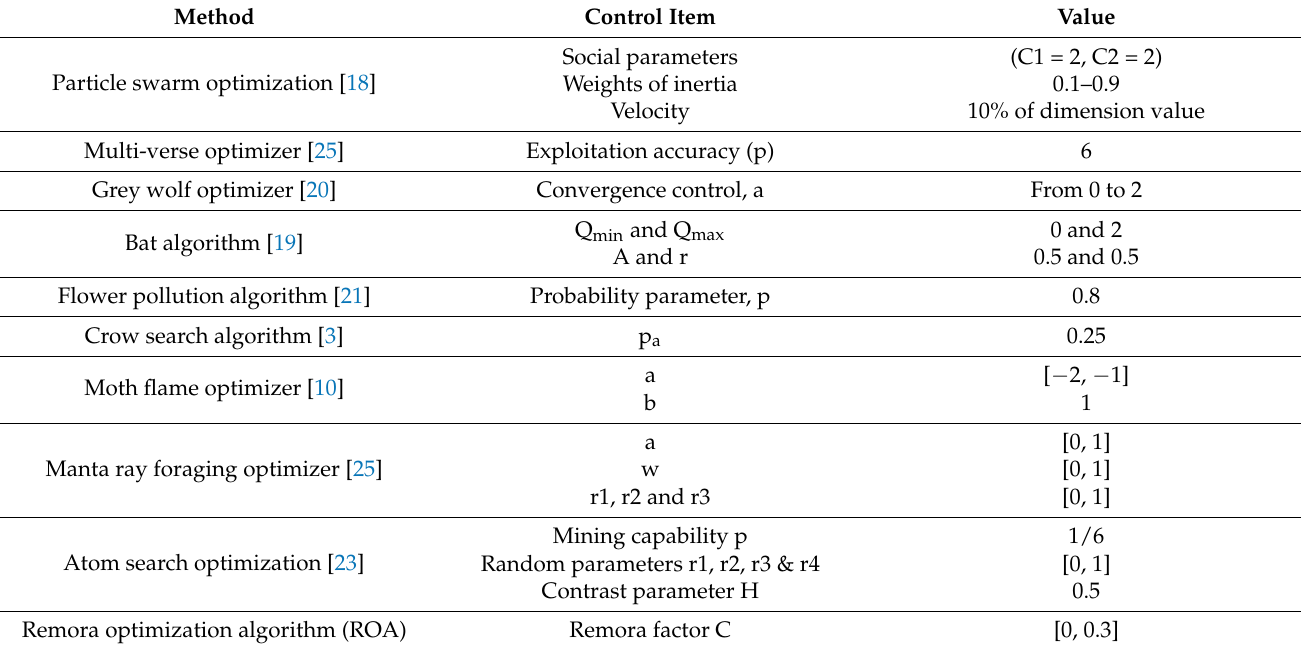
Table 1. Control parameters of different